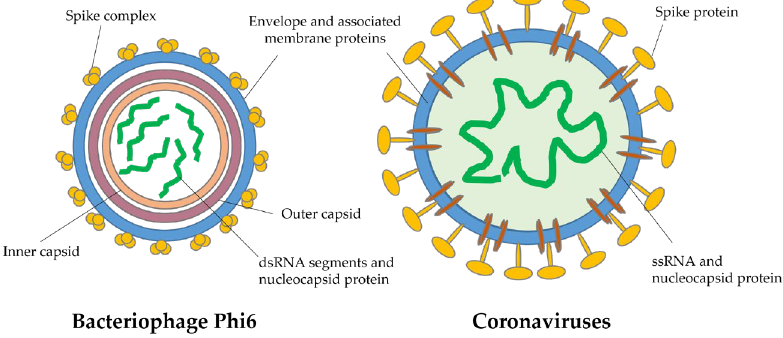
Figure 5. Schematic structures of viral particles of coronaviruses and bacteriophage Phi 6. The latter is considered a good and safe surrogate for studying enveloped RNA viruses.